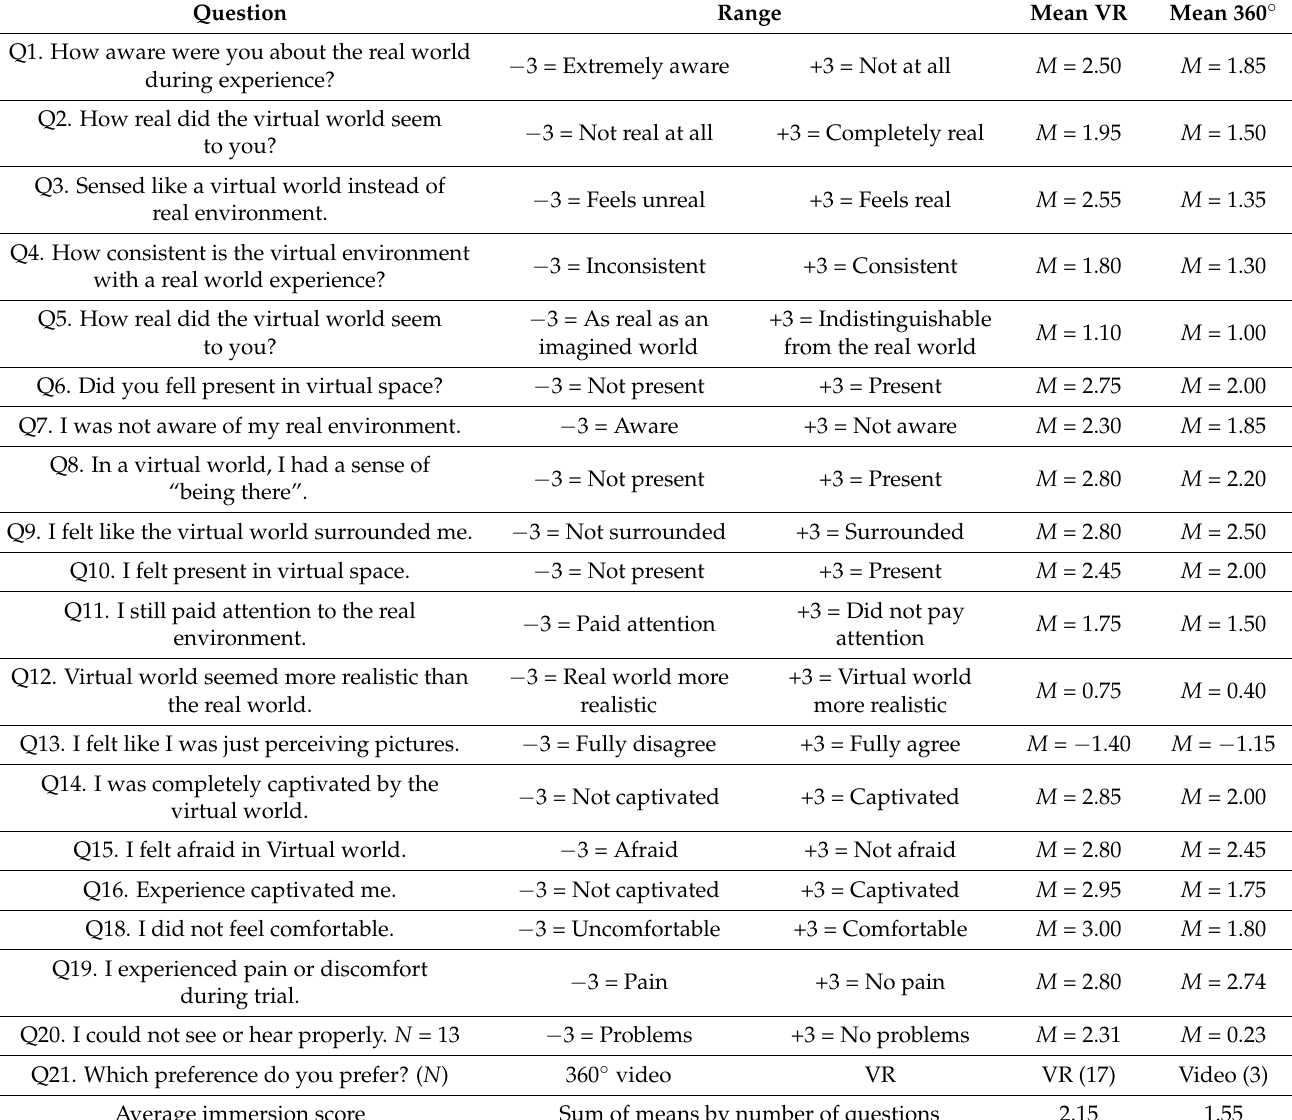
Table 1. Comparison between questionnaire results for each technology using mean